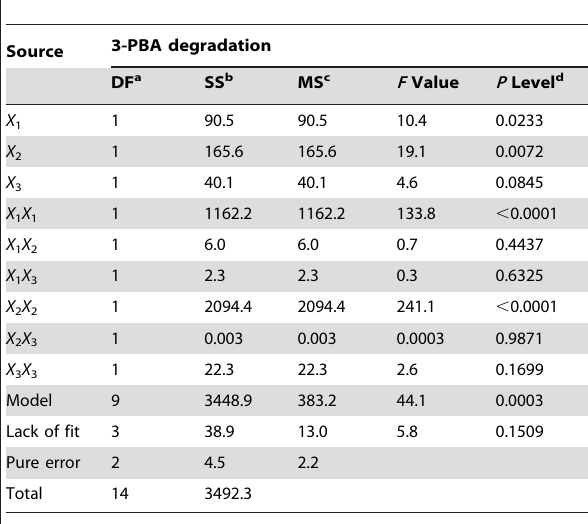
N Figure 2. Degradation and utilization of 3-PBA during growth of strain DG-02. m , degradation kinetics in MSM supplemented with 3-PBA , degradation kinetics in MSM supplemented with 1% glucose as the additional source of carbon; g , non-inoculated as the sole carbon source; control (degradation); & , cell growth in MSM supplemented with 3-PBA as the sole carbon source; ¤ , cell growth in MSM supplemented with 1% glucose as the additional source of carbon; % ; non-inoculated control (growth). Error bars represent the standard deviation of three replicates. doi:10.1371/journal.pone.0050456.g002 Table 3. Analysis of variance (ANOVA) for the fitted quadratic polynomial model for 3-PBA